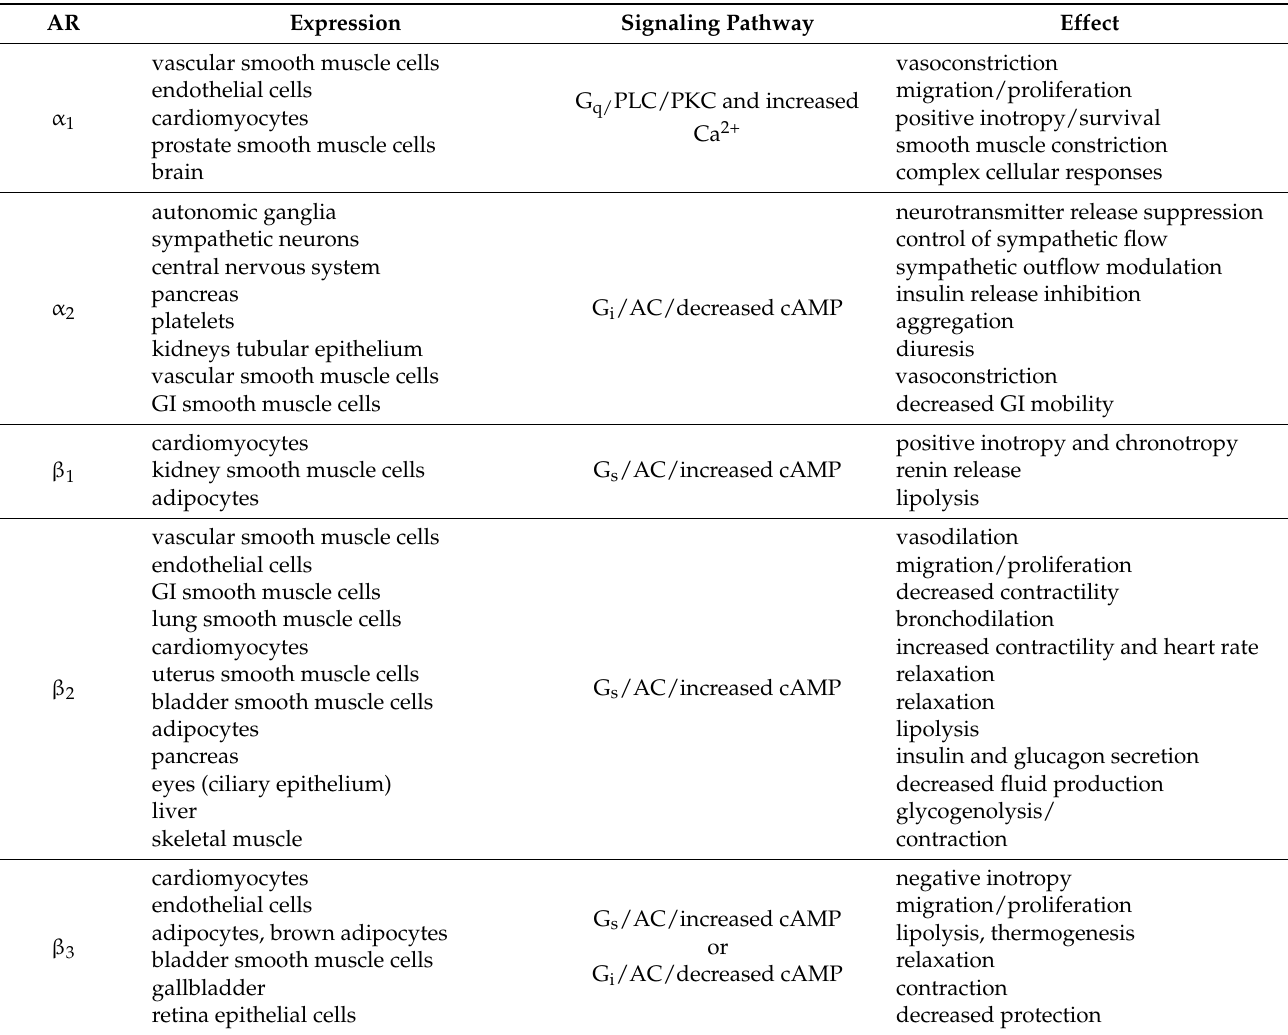
Table 1. Distribution and functions of